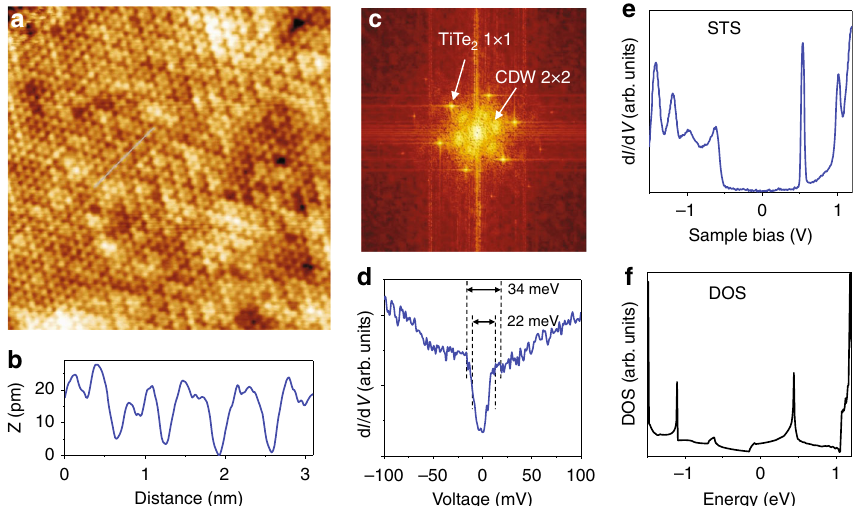
Fig. 4 STM/STS data for single-layer TiTe 2 at 4.2 K. a An image taken from 1-TL TiTe 2 . It shows the triangular lattice of the top Te atomic layer. The experimental conditions are: size 12 × 12 nm, sample bias 105 mV, and tunneling current 1.0 nA. The pattern also shows a weak (2 × 2) modulation that is interrupted by domain boundaries. b The height pro fi le along the light blue line, reveals a (2 × 2) height modulation of just about 5 pm. c A pattern derived from the Fourier transform of the image. The (1 × 1) lattice spots are sharp; the (2 × 2) CDW spots are weak and broad. d A STS differential conductance curve revealing a pseudogap at the Fermi level. e STS data over a wide energy range. f Computed density of states (DOS) for 1-TL TiTe 2 . The peak positions are in close agreement with those in the STS